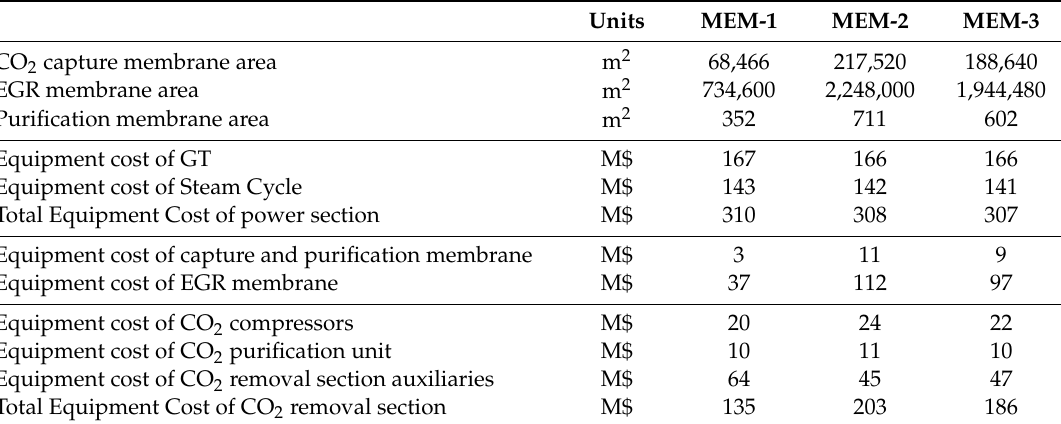
Table 11. Main results of equipment cost assessment for membrane.